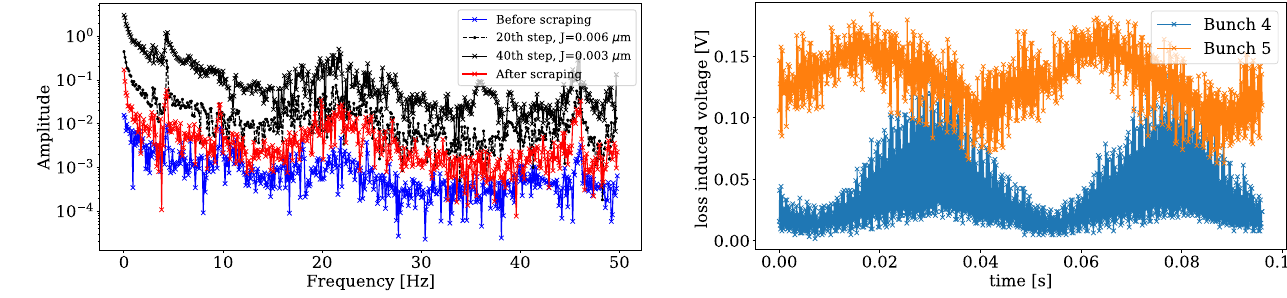
17. Frequency analysis of the beam 1 vertical response for four moments. Before, during (in two steps), and after the scraping in fill 6052 (see Table III for details).